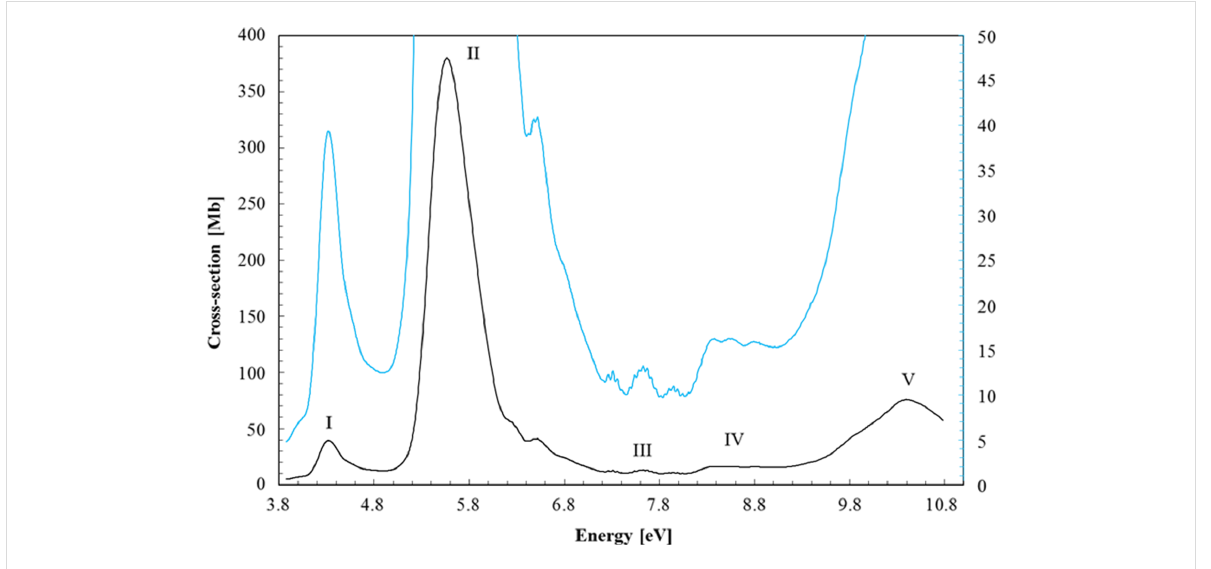
Figure 1: High-resolution VUV photoabsorption spectrum of W(CO) 6 in the photon energy range of 3.9–10.8 eV. The blue curve has the (right) ordi- nate set to a maximum of 50 Mb to bring out the rich fine structure in the spectrum.